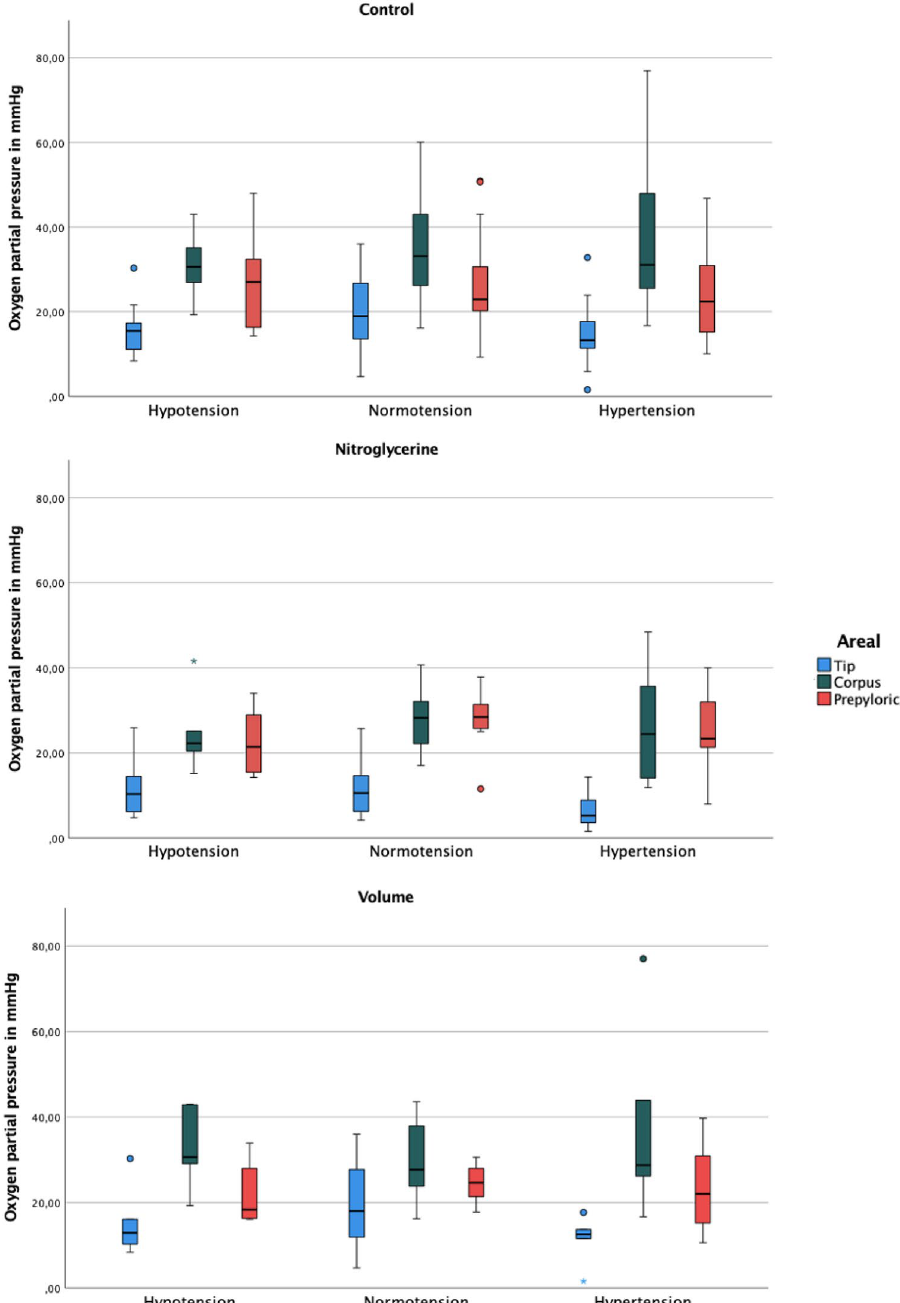
Figure 7. Tissue oxygenation of all groups shown as boxplots. Circles (°) represent mild outliers and asterisks (*) represent extreme outliers. In all groups, the tip shows significantly reduced tissue oxygen partial pressure. In the control group, tissue oxygenation is highest in the corpus. Administration of nitroglycerine results in no significant differences between corpus and prepyloric regions. Hypervolemia also shows the highest oxygenation levels in the corpus. There were no statistically significant changes between the measurement times (hypotension, normotension, and hypertension,